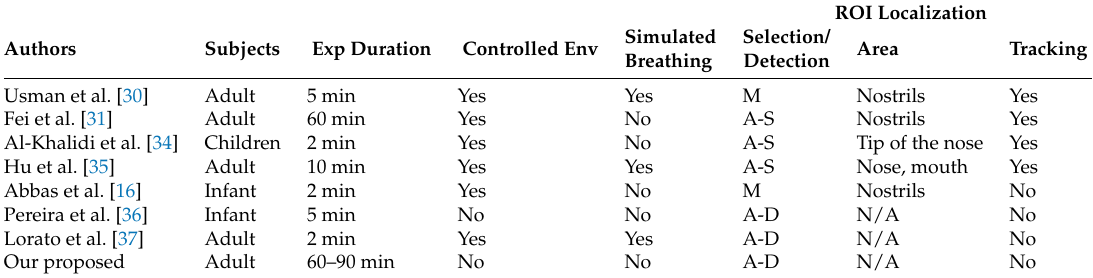
Table 1. A research review of the thermal imaging-based method for respiration monitoring of sleeping